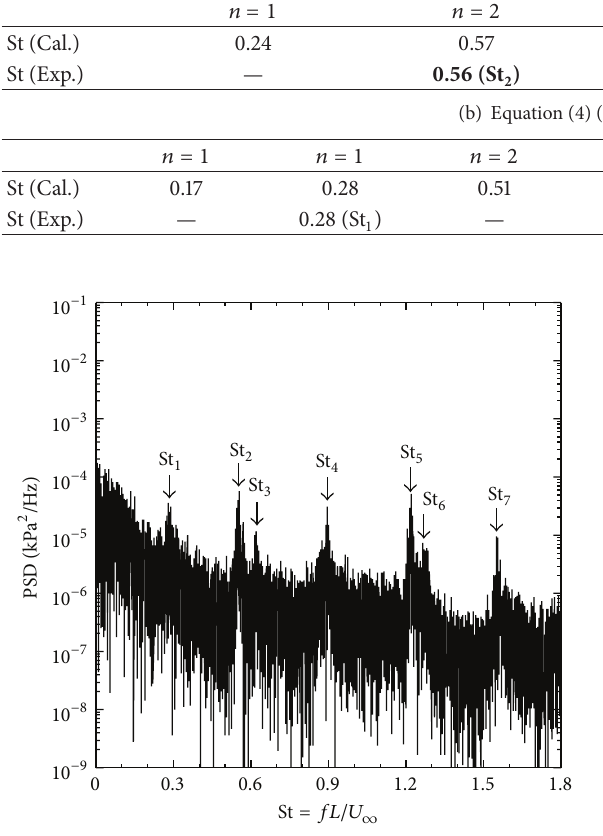
Figure 4: Power spectral density of pressure oscillation for 𝐿/𝐷 = 1.8